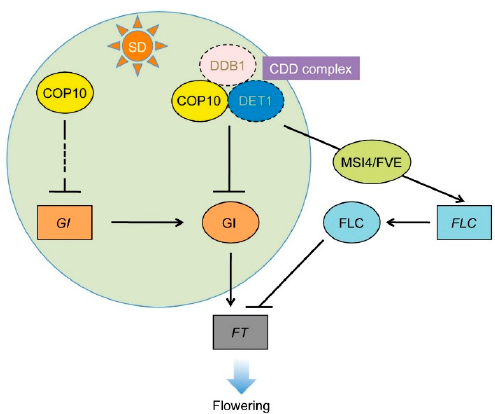
Figure 7. Working model of COP10 function in flowering repression . COP10 suppresses FT expression via multiple routes in the photoperiod and autonomous pathways. In the photoperiod flowering pathway, COP10 functions in floral repression by regulation of GI at the transcriptional and post-translational levels during daytime under SD. COP10, probably without forming the CDD complex, blocks formation of the FKF1-GI complex by repressing expression of FKF1 and GI during the daytime. Second, COP10 physically interacts with GI, and might repress its binding to the FT promoter. In the autonomous pathway, COP10 modulates FLC chromatin through interaction with MSI4 to induce FLC expression. Genes and proteins are represented as rectangles and ovals, respectively.